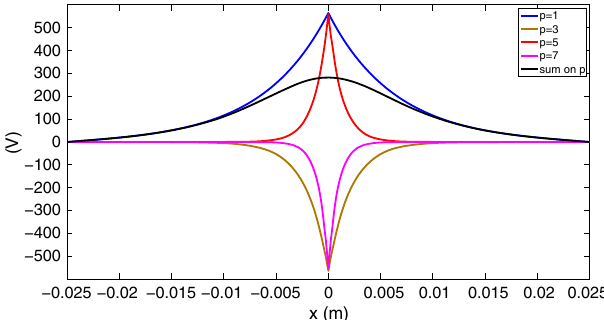
ˆ E x Þ and the yp ð ˆ λ ð k Þ is omitted.